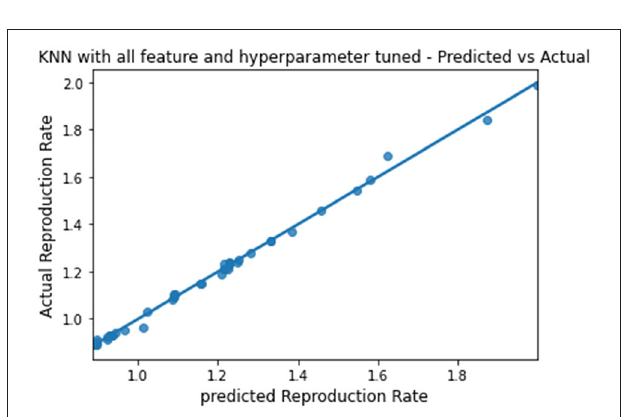
FIGURE 8 | Graph describing the predicted value vs. actual value of KNN.